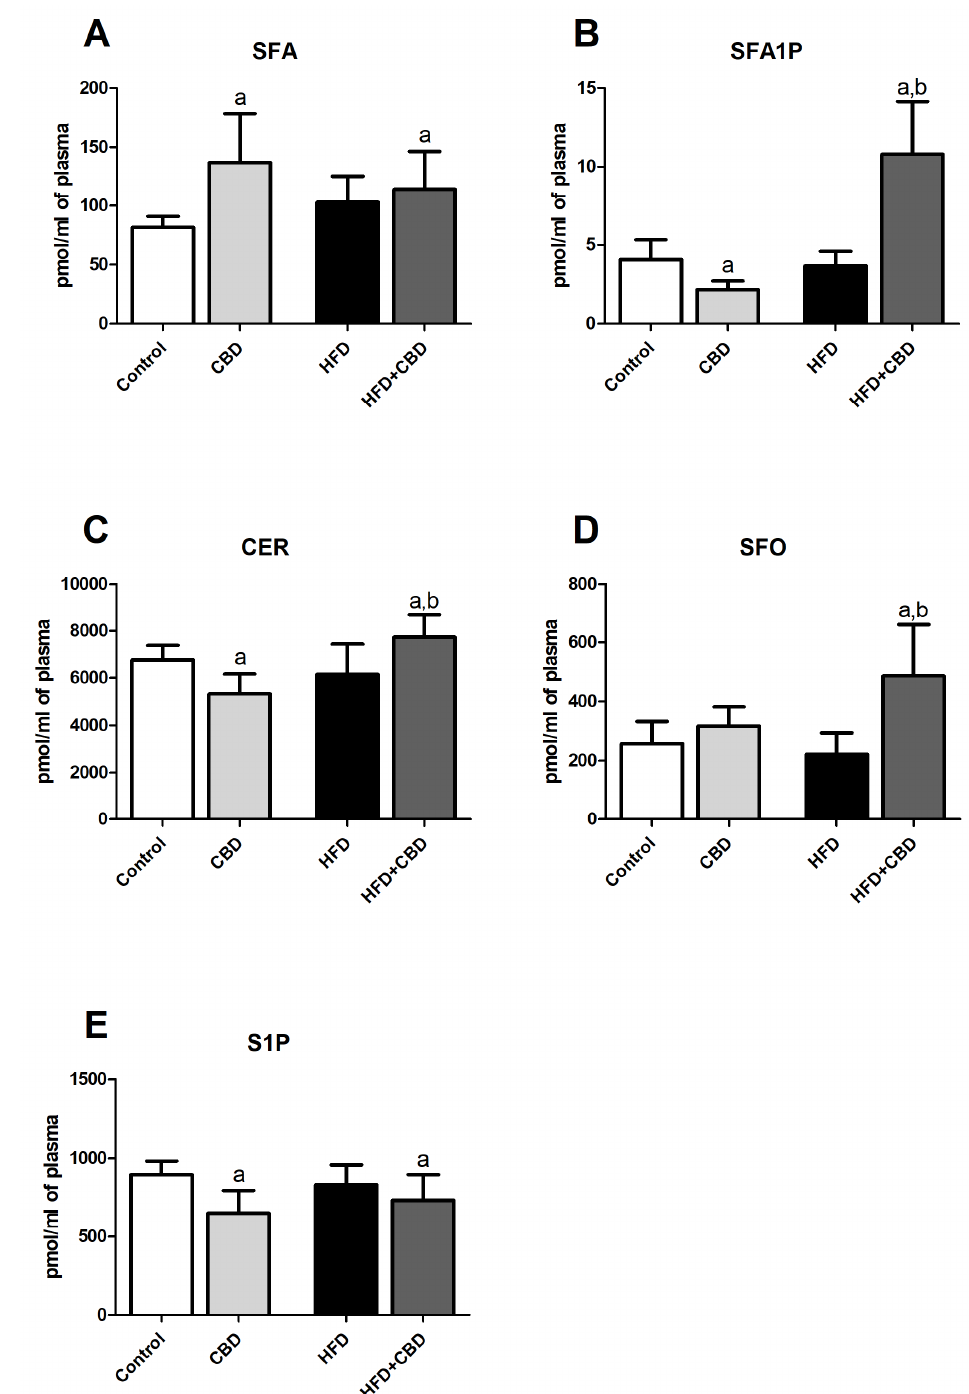
Figure 2. The content of plasma sphingolipids, i.e., sphinganine—SFA ( A ), sphinganine-1- phosphate—SFA1P ( B ), ceramide—CER ( C ), sphingosine—SFO ( D ), and sphingosine-1-phosphate— S1P ( E ) after 2-week cannabidiol (CBD) administration in the rats fed a standard diet (Control) or a high-fat diet (HFD). The components of sphingolipid pathway were measured by high-performance liquid chromatography (HPLC) method. The results are expressed as mean values ± SD and are based on ten independent determinations in each experimental group. a p < 0.05 significant difference vs. control group; b p < 0.05 significant difference vs. high-fat-fed